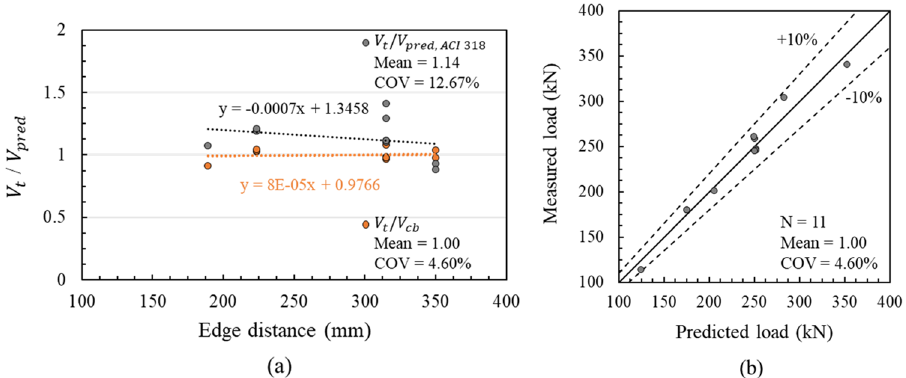
Figure 18. Comparison between predicted and measured loads: ( a ) edge distance, ( b ) predicted load by Eq.